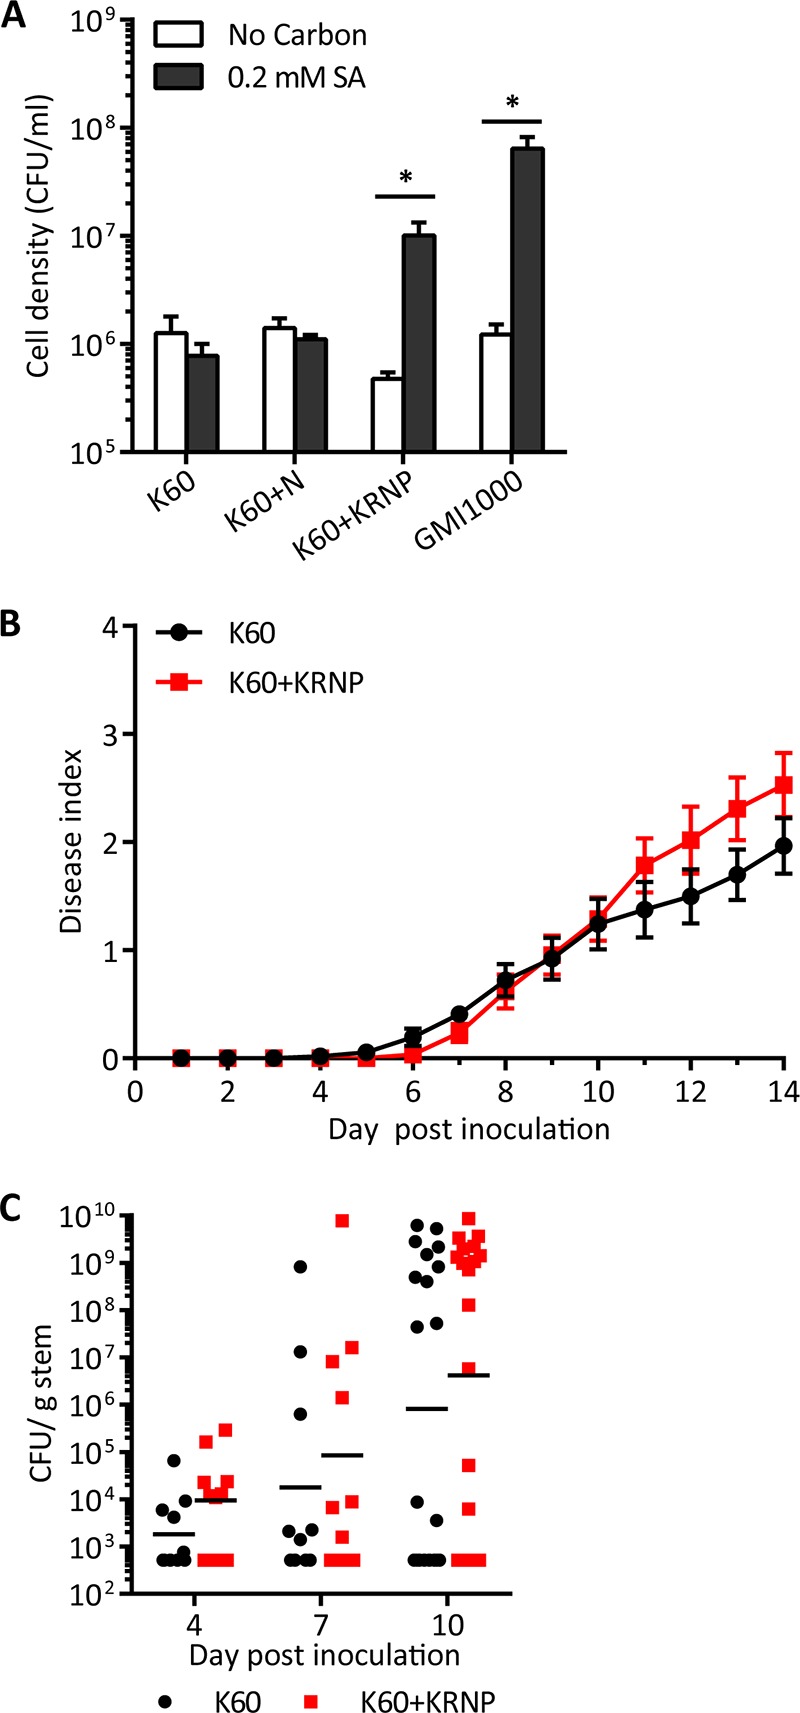
SA degradation increases virulence of R. solanacearum strain K60 on tobacco. (A) In vitro growth of K60 wild-type (K60), K60 with nagAaGHAbIKLGMI1000 genes (K60+N), K60 with pcaKGMI1000, RSc1092GMI1000, nagAaGHAbIKLGMI1000, and RSc1084GMI1000 (K60+KRNP), and GMI1000 wild type on SA as sole carbon source. Asterisks indicate P was <0.05 (Student’s t test). (B) Virulence of strains K60 and K60+KRNP following soil soak inoculation of 3- to 4-week-old tobacco with unwounded roots. Data are the average results for 6 experiments with 45 total plants per strain (P < 0.05; repeated measures ANOVA). (C) R. solanacearum density in tobacco stem following soil soak inoculation. Each symbol represents the bacterial population size in a single plant (P > 0.05 at 4, 7, and 10 days post-soil soak inoculation; Mann-Whitney test).